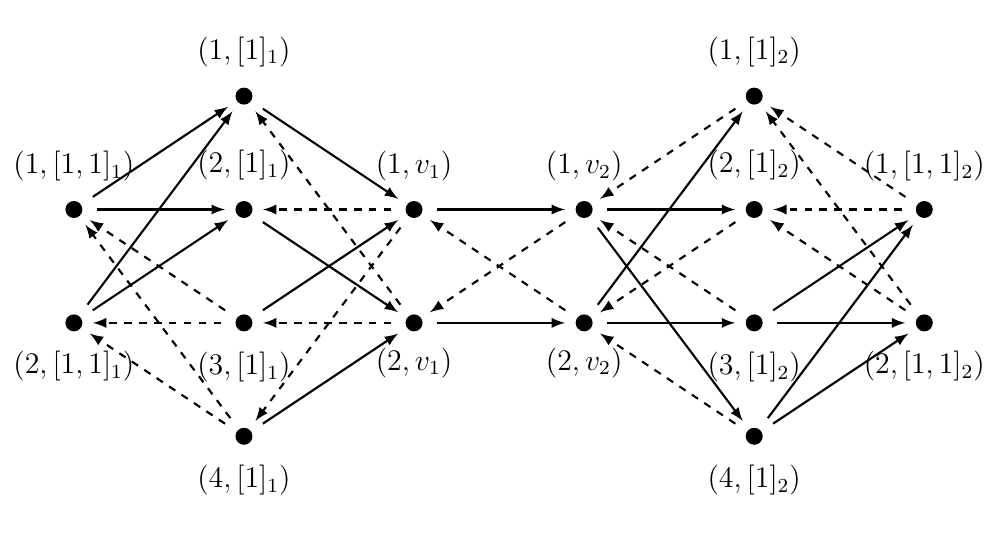
Figure 4: Orientation D for H